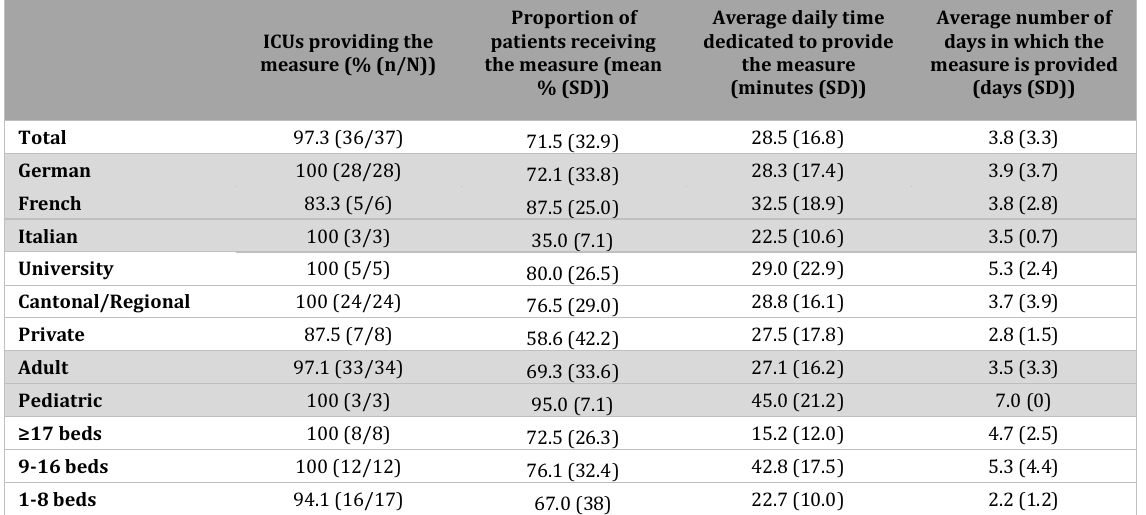
ICUs providing the measure (% (n/N))